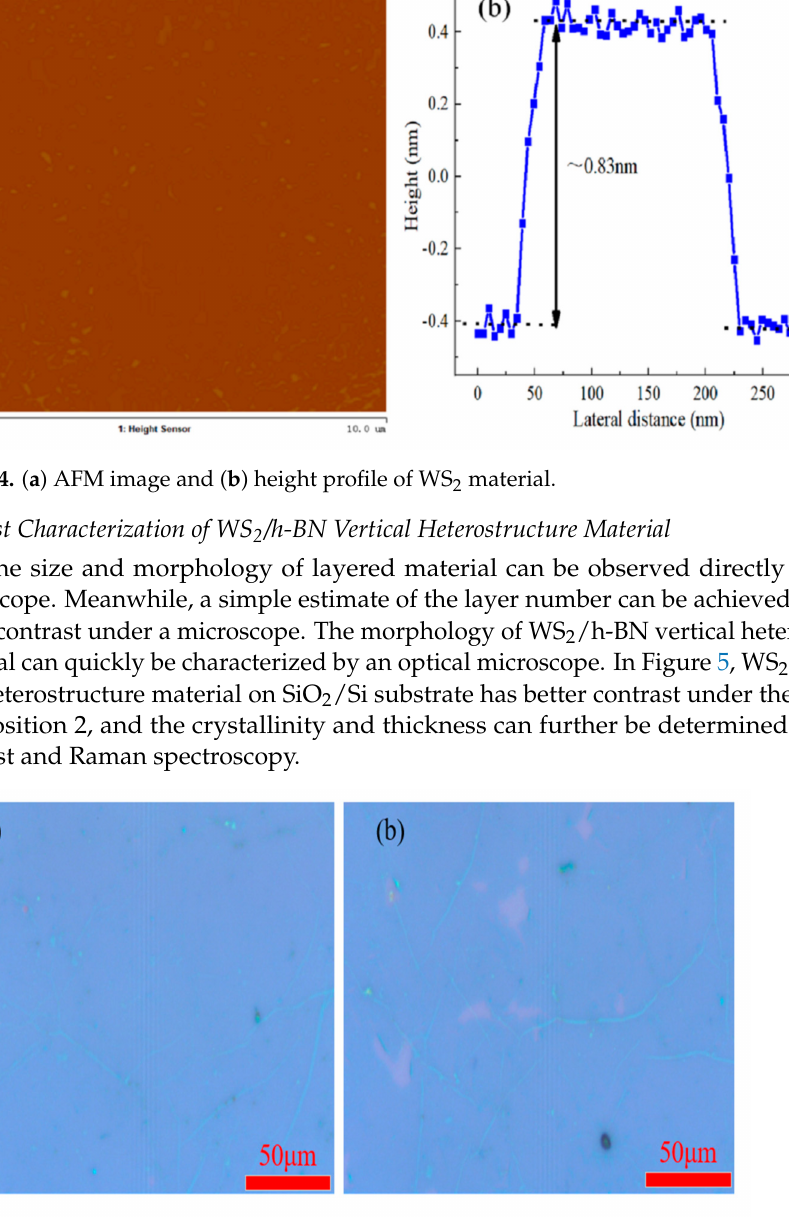
Figure 5. Optical microscope image of WS 2 /h-BN vertical heterostructure material. ( a ) position 1; ( b ) position